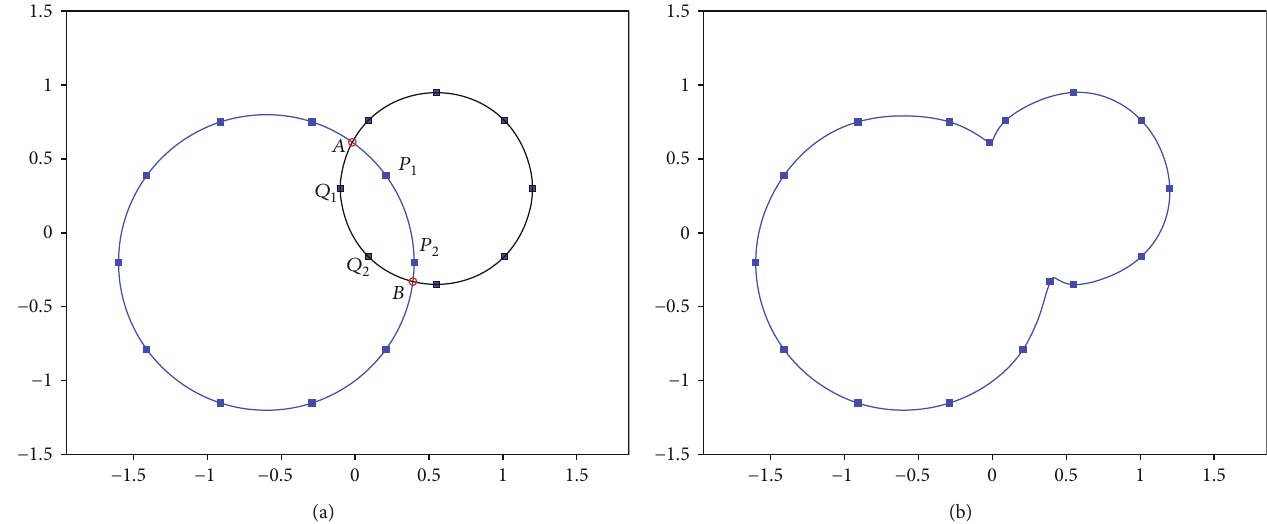
Figure 2: Fit the contour of two coalesced bubbles using B-spline curves. (a) Find intersection points and detect contour points. (b) Remove points that are located in the inner area, and fi t those contour points by the closed B-spline